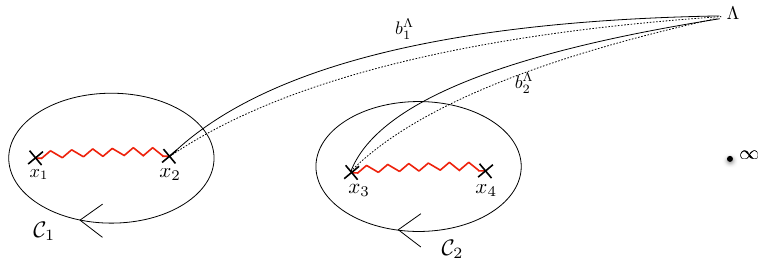
Figure 1 . Path of integrals in the period calculations